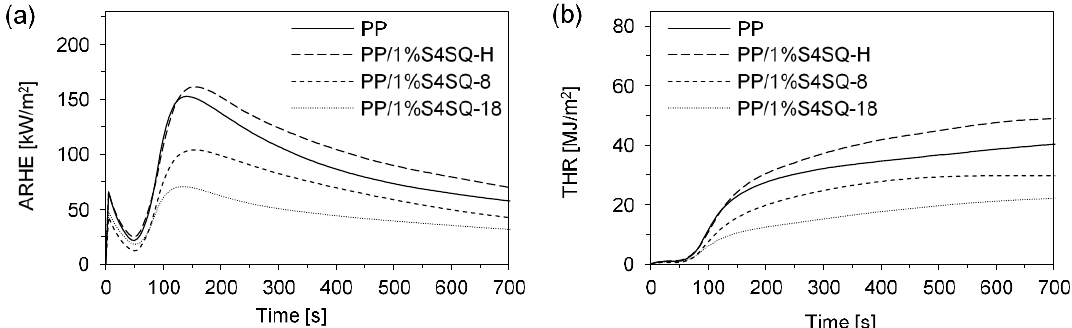
Figure 7. Heat evolving during combustion for neat PP and PP/S4SQ composites: ( a ) average rate of heat emission (AHRE) and ( b ) total heat released (THR).